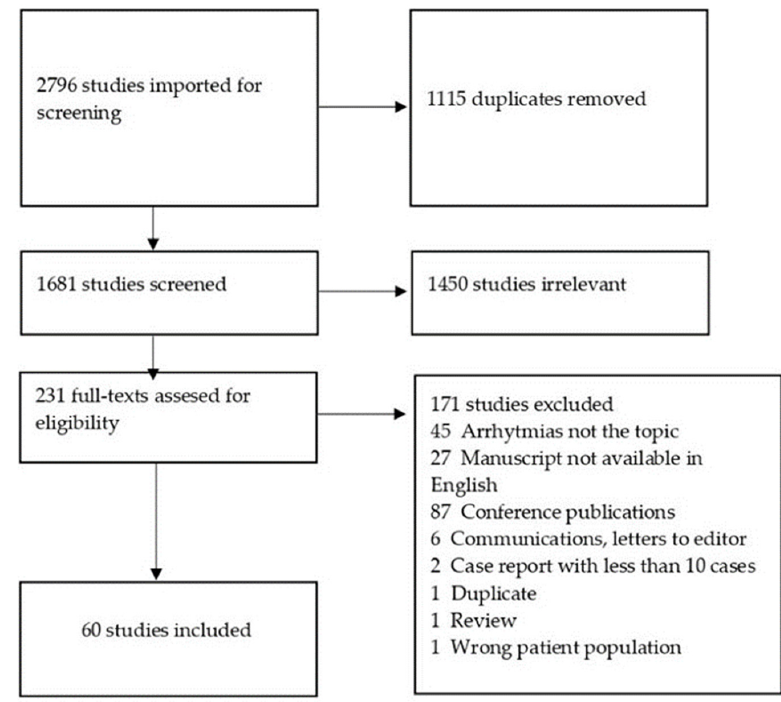
Figure 1. PRISMA flowchart.